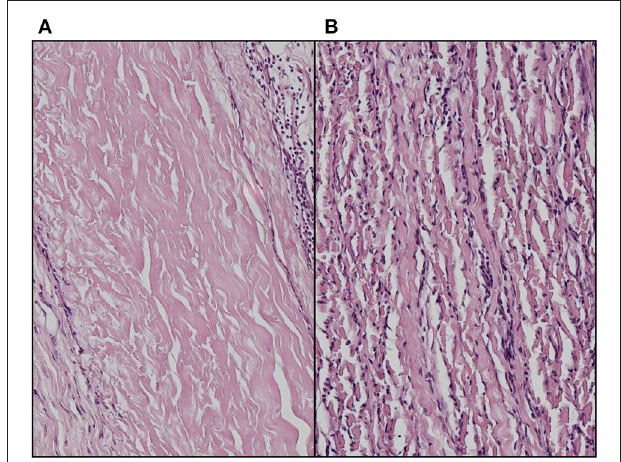
FIGURE 2 | Absence of inflammatory infiltrate in (A) electrophoretically enhanced anionic detergent decellularization of bovine pericardium following 6-week subdermal implantation in the rat compared to (B) non-ionic decellularization with exhaustive washing (Haematoxylin & Eosin stain).